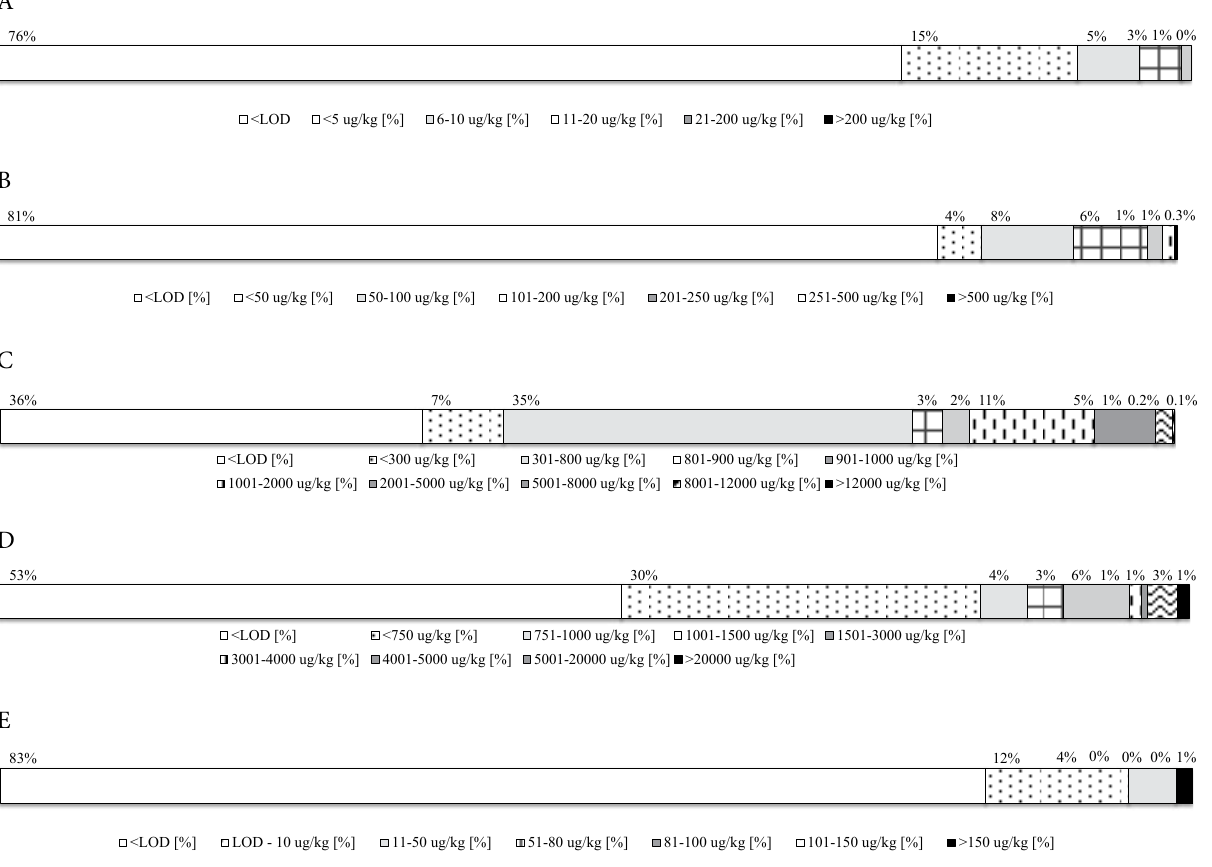
Figure 1. Distribution of mycotoxins occurrence by contamination range (percentage of samples), determined by ELISA. A, Afla; B, ZON; C, DON; D, FUM; E,